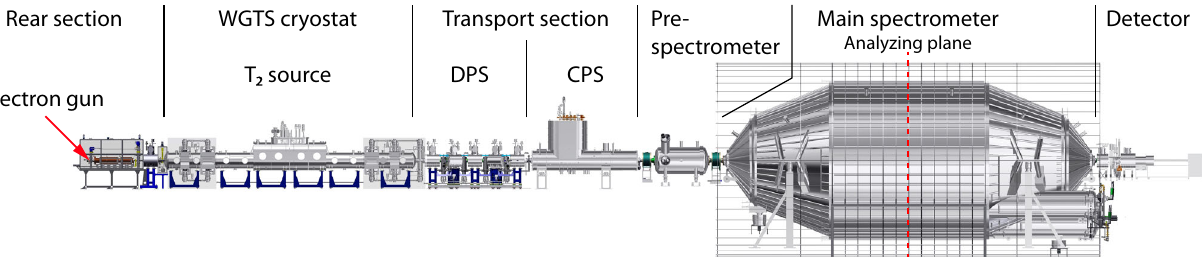
Fig. 1 Overview of the KATRIN experiment. The main components are from left to right: The rear section containing calibration and mon- itoring systems as well as the electron gun (see Fig. 2) used in this work; the 10-m-long windowless gaseous tritium source (WGTS) with differential pumps on both sides; the transport section consisting of a